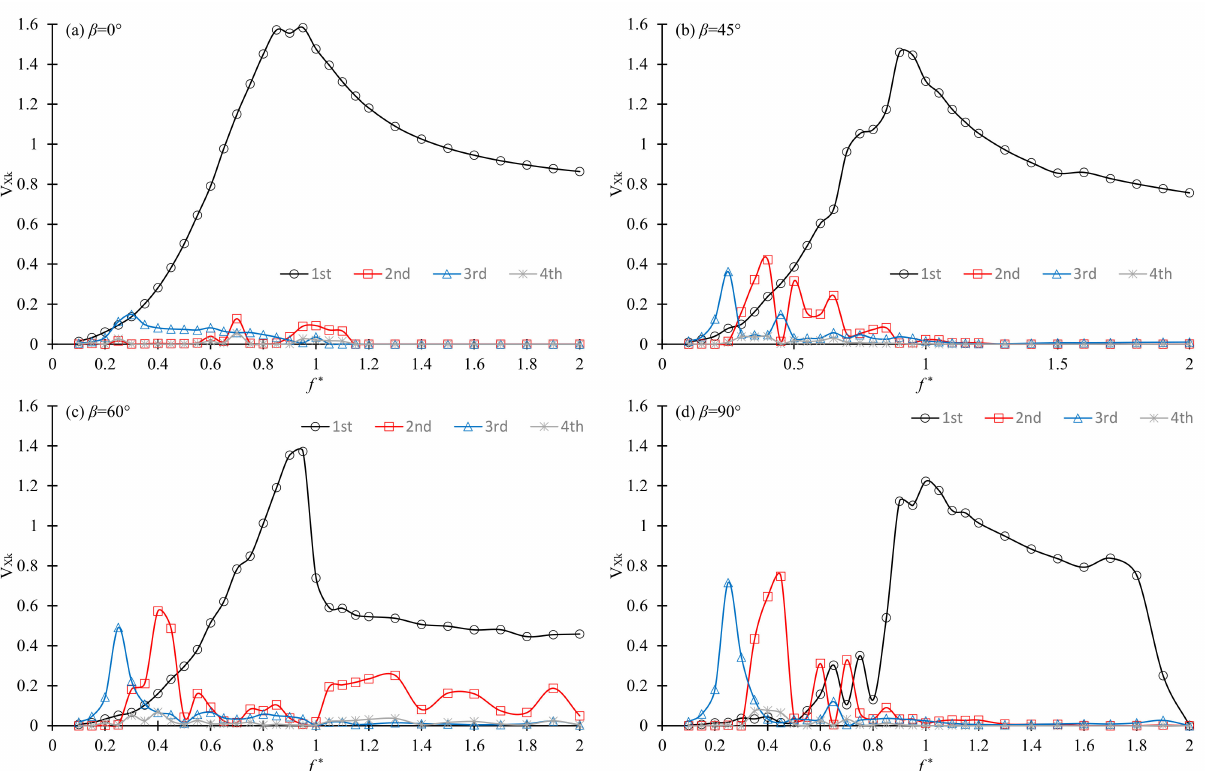
Figure 18. Variation in the harmonic components of the velocity of the cylinder with the natural frequency ratio for KC =